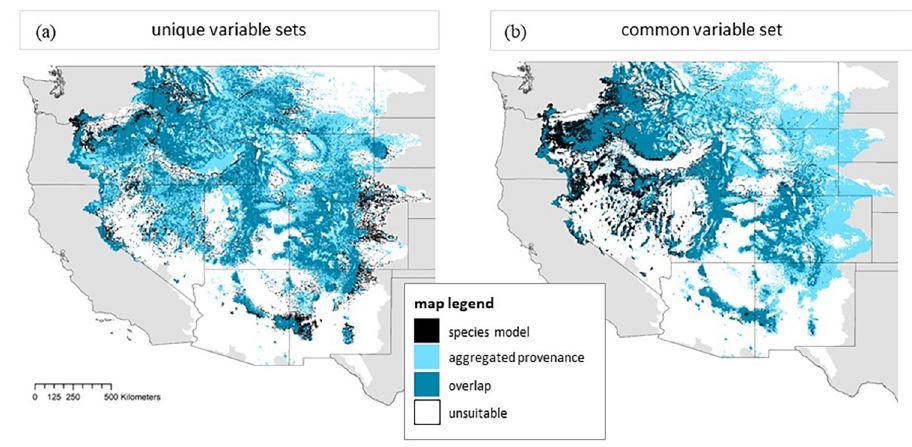
Fig 3. Maps representing the geographic overlap of aggregated population models with species models across the Western United States. Panel (A) uses models built with unique sets of predictor variables and panel (B) uses models built with a common set of predictor variables. Black regions represent suitable habitat predicted only by the species model, dark teal regions represent regions of model overlap or agreement on suitable habitat between the species model and the aggregated population models, and light blue represents regions predicted as suitable by the aggregated population model (at least 1 individual population model predicts suitable landscape in those locations). White regions are areas predicted unsuitable by all models. Maps are projected in WGS84 (World Geodetic System 1984) or EPSG 4326. The background map of the United States represented in this figure was downloaded from the U.S. Census (Cartographic Boundary Files (census.gov)).